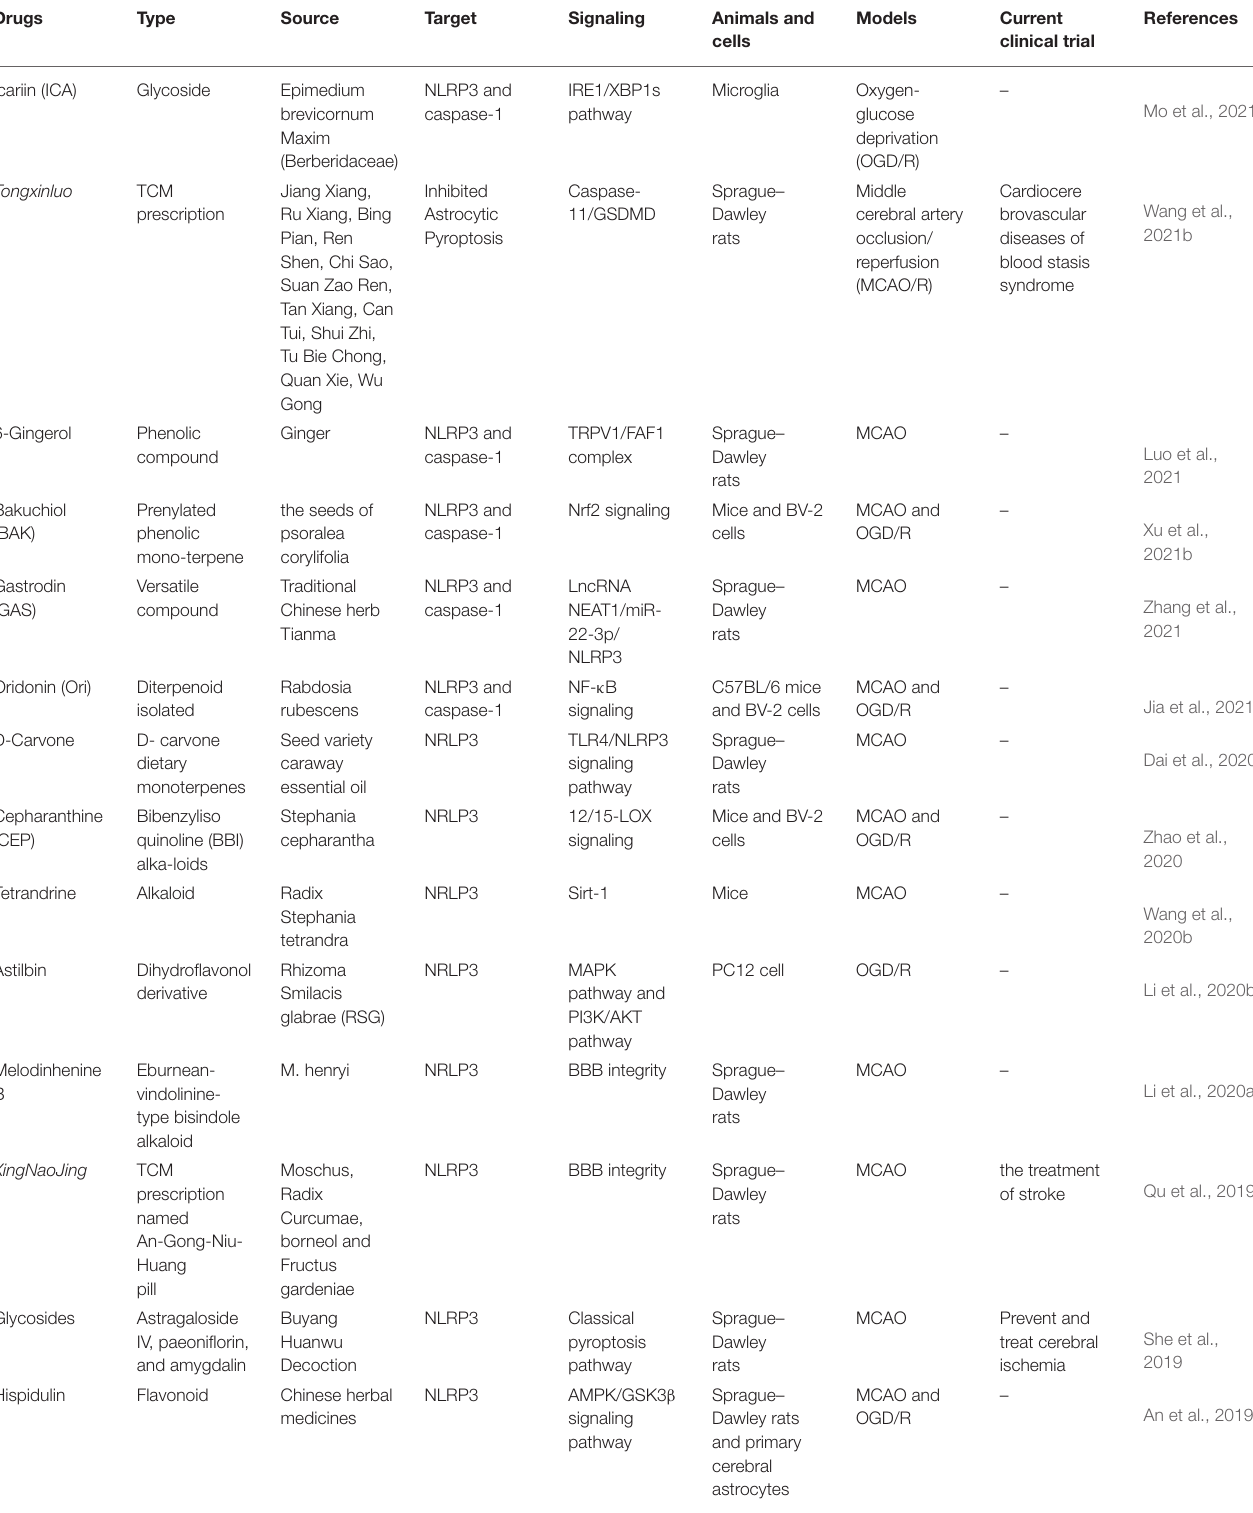
TABLE 2 | Herbal drugs that target NLRP3 inflammasome after cerebral ischemia–reperfusion (I/R) injury.